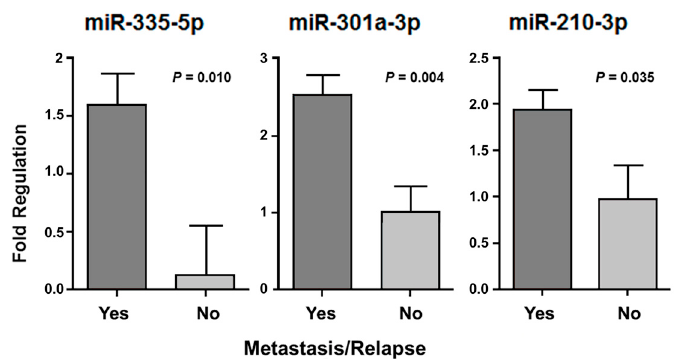
Figure 5. The miR-335-5p, miR-301a-3p, and miR-210-3p with significant expression difference in patients who had undergone adjuvant treatment and presented metastasis or tumor relapse, independent of the tumor histological type.